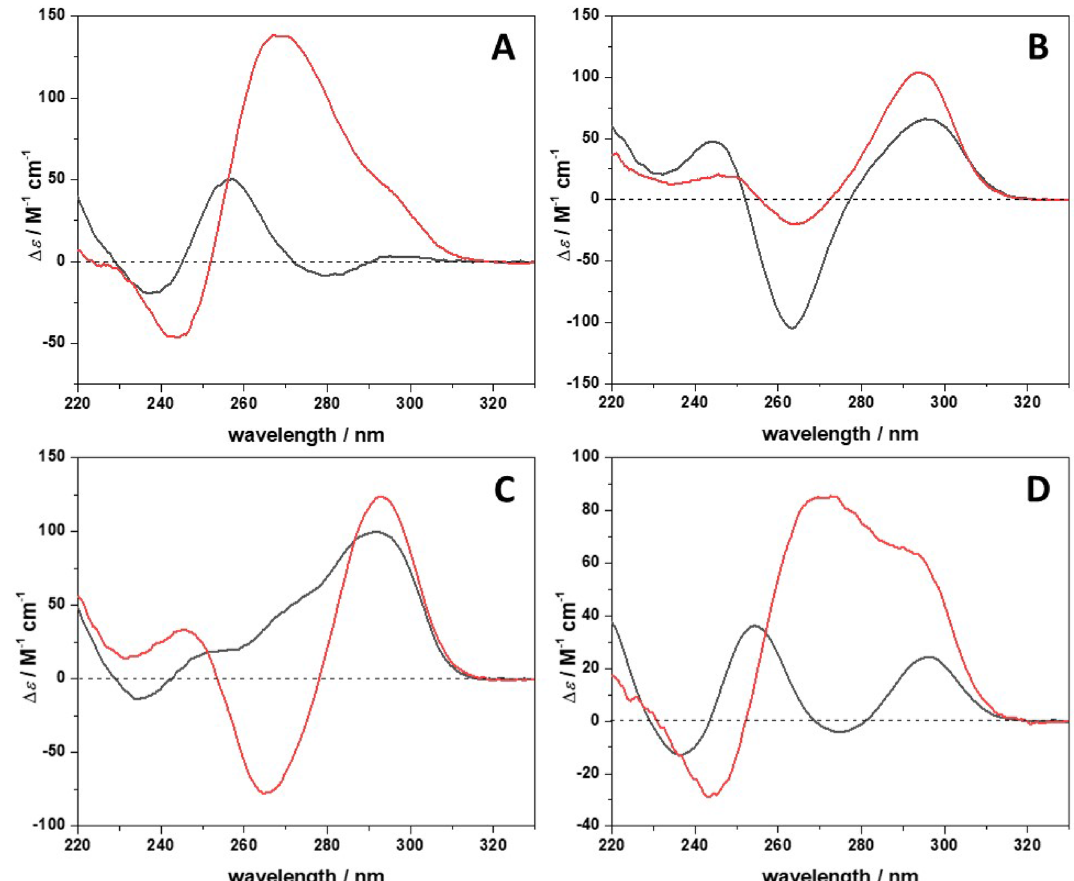
Figure 2. Circular dichroism (CD) spectra of a 30 µM solution of 22AG in the absence (black spectra) and in the presence of 300 µM ThT (red spectra) in ( A ) 30 mM Tris, pH 7.4, ( B ) in the presence of 60 mM NaCl, ( C ) in the presence of 60 mM KCl, and ( D ) in the presence of 25 wt% Ficoll. All experiments were carried out in a 0.1 cm path length quartz cuvette at the temperature of 25